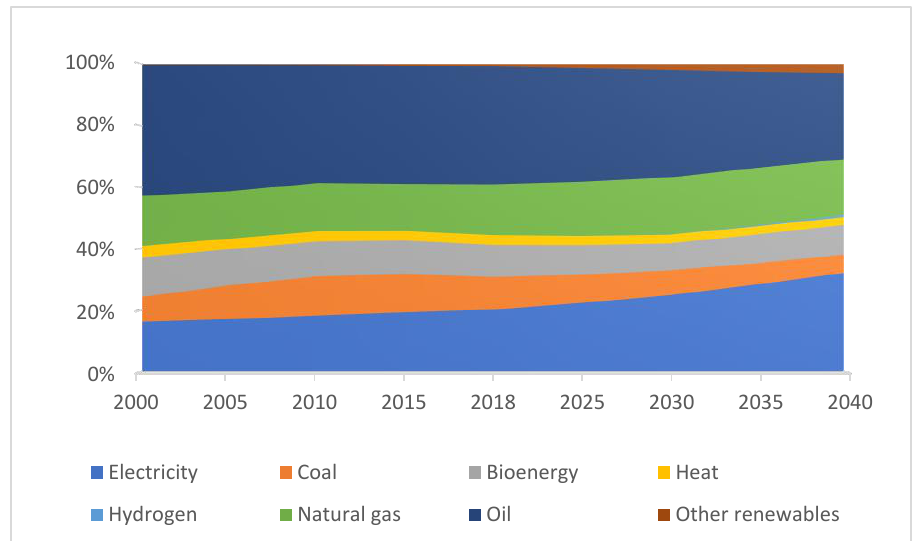
Figure 1. Share of global final energy consumption by fuel in the Sustainable Development Scenario, 2000 – 2040 [25].